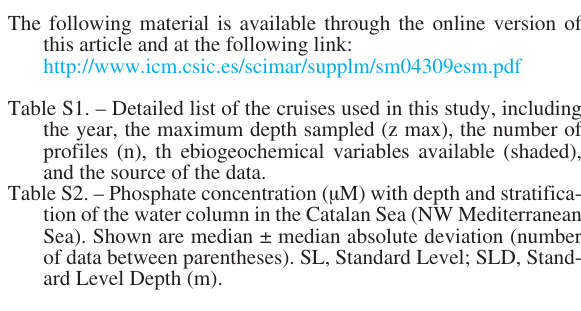
Table S7. – Chlorophyll a concentration (µg L -1 ) with depth and stratification of the water column in the Catalan Sea (NW Medi-